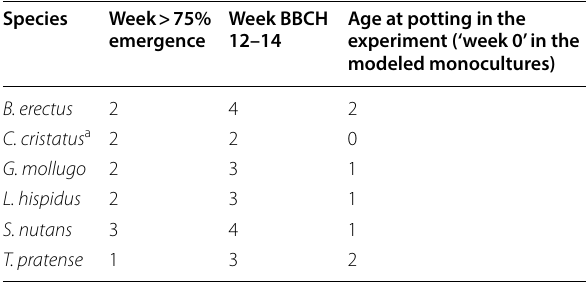
Table 2 Compared biomasses in the model and the